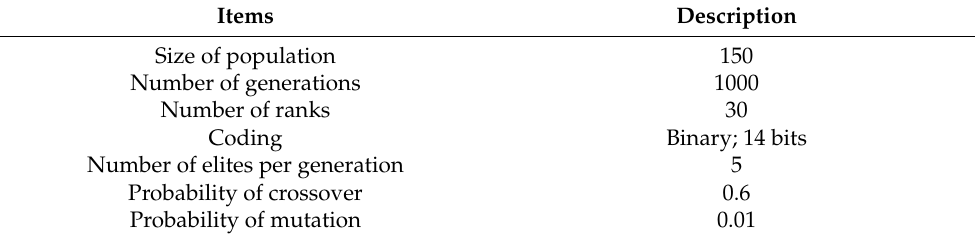
Table 2. Configuration of multiobjective genetic algorithm